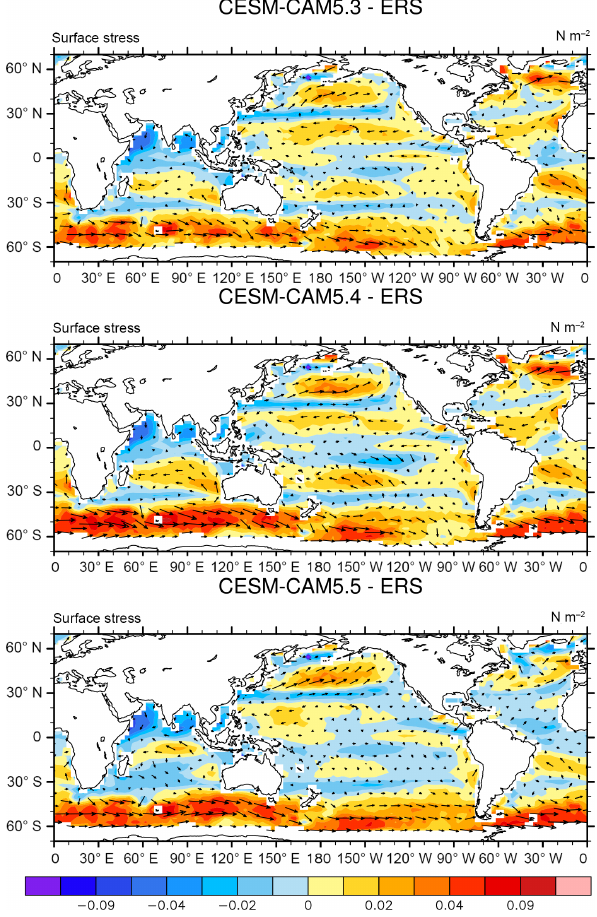
Figure 9. Same as Fig. 2 but for surface stress biases computed relative to ERS